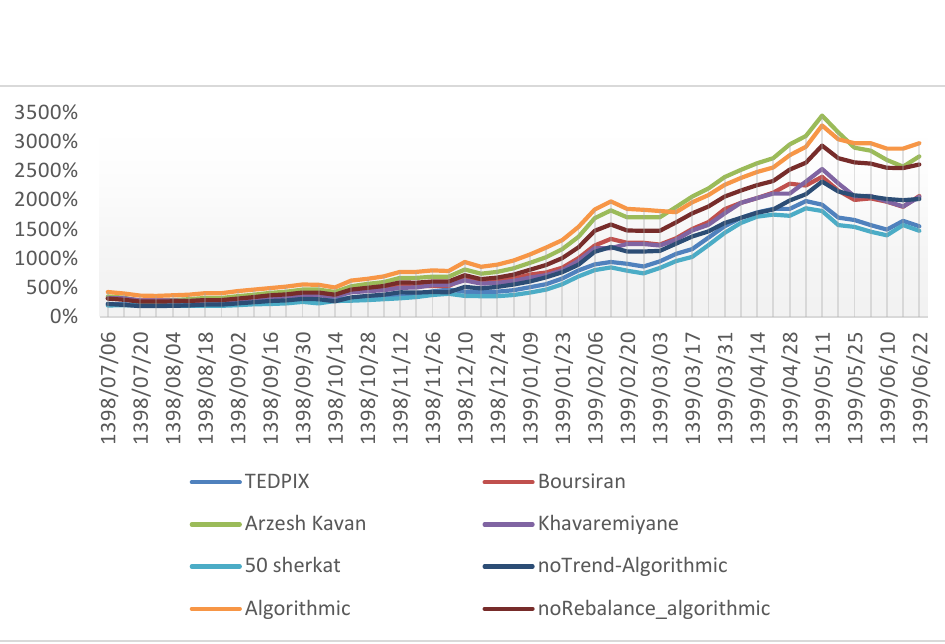
Figure 6.2 Comparison of return on net asset value from 1398/06/30 to 1399/06/30